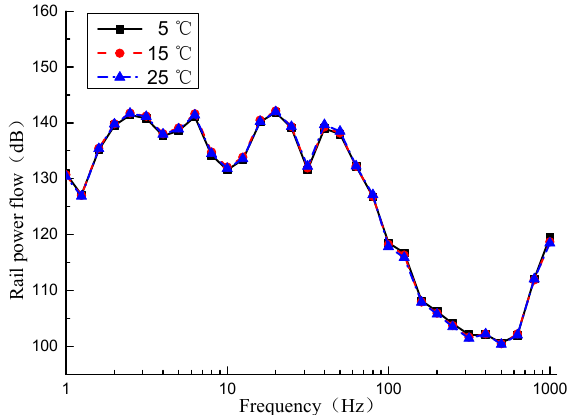
Figure 12. Rail power